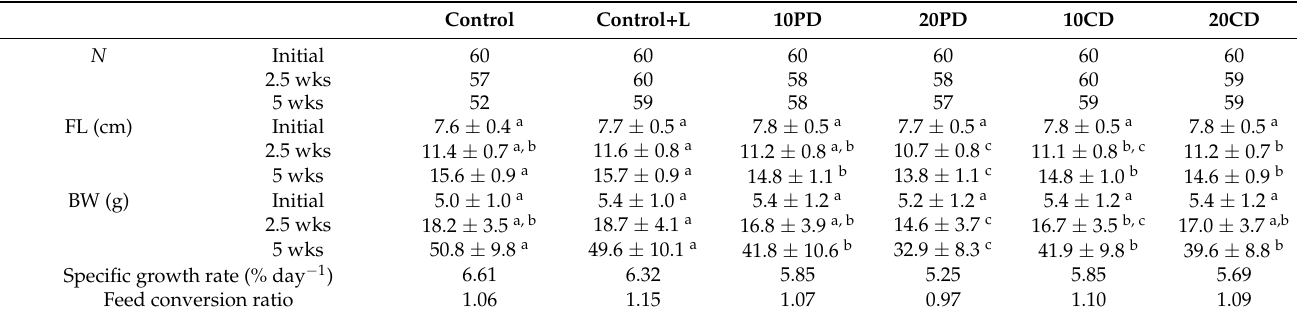
Values for FL and BW are represented by means ± S.D. Different letters in row indicate statistically significant differences according to Kruskal–Wallis test and Mann–Whitney test with Holm’s correction for post hoc comparison ( p < 0.05). Abbreviations: FL, fork length; BW, body